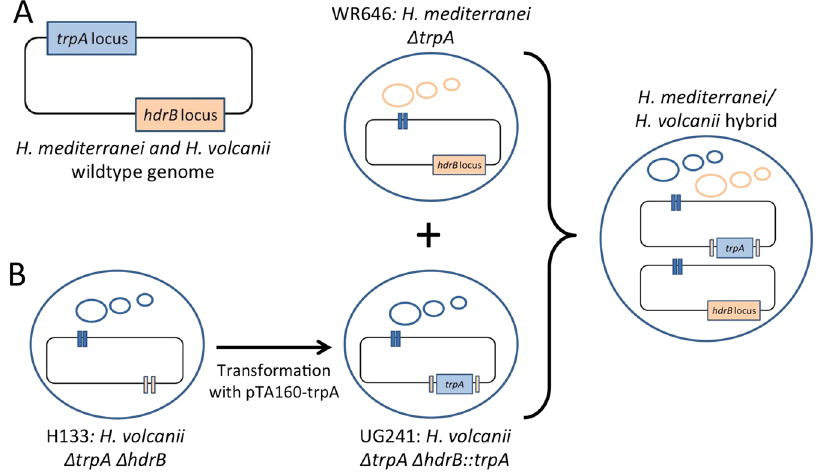
Figure 1. Generation of stable H . volcanii × H . mediterranei hybrids. ( A ) The genomic organization of the selectable markers involved in the study. ( B ) Generation of a stable hybrid. H133 was transformed with pTA160 trpA , and upon selection on media lacking thymidine the trpA marker was integrated in the hdrB locus, generating UG241. UG241 was mated with WR646, which are autotrophs for thymidine and tryptophan, respectively. The mated colonies were selected on a media lacking thymidine and tryptophan. Small circles indicate the plasmids and the rectangle represents the